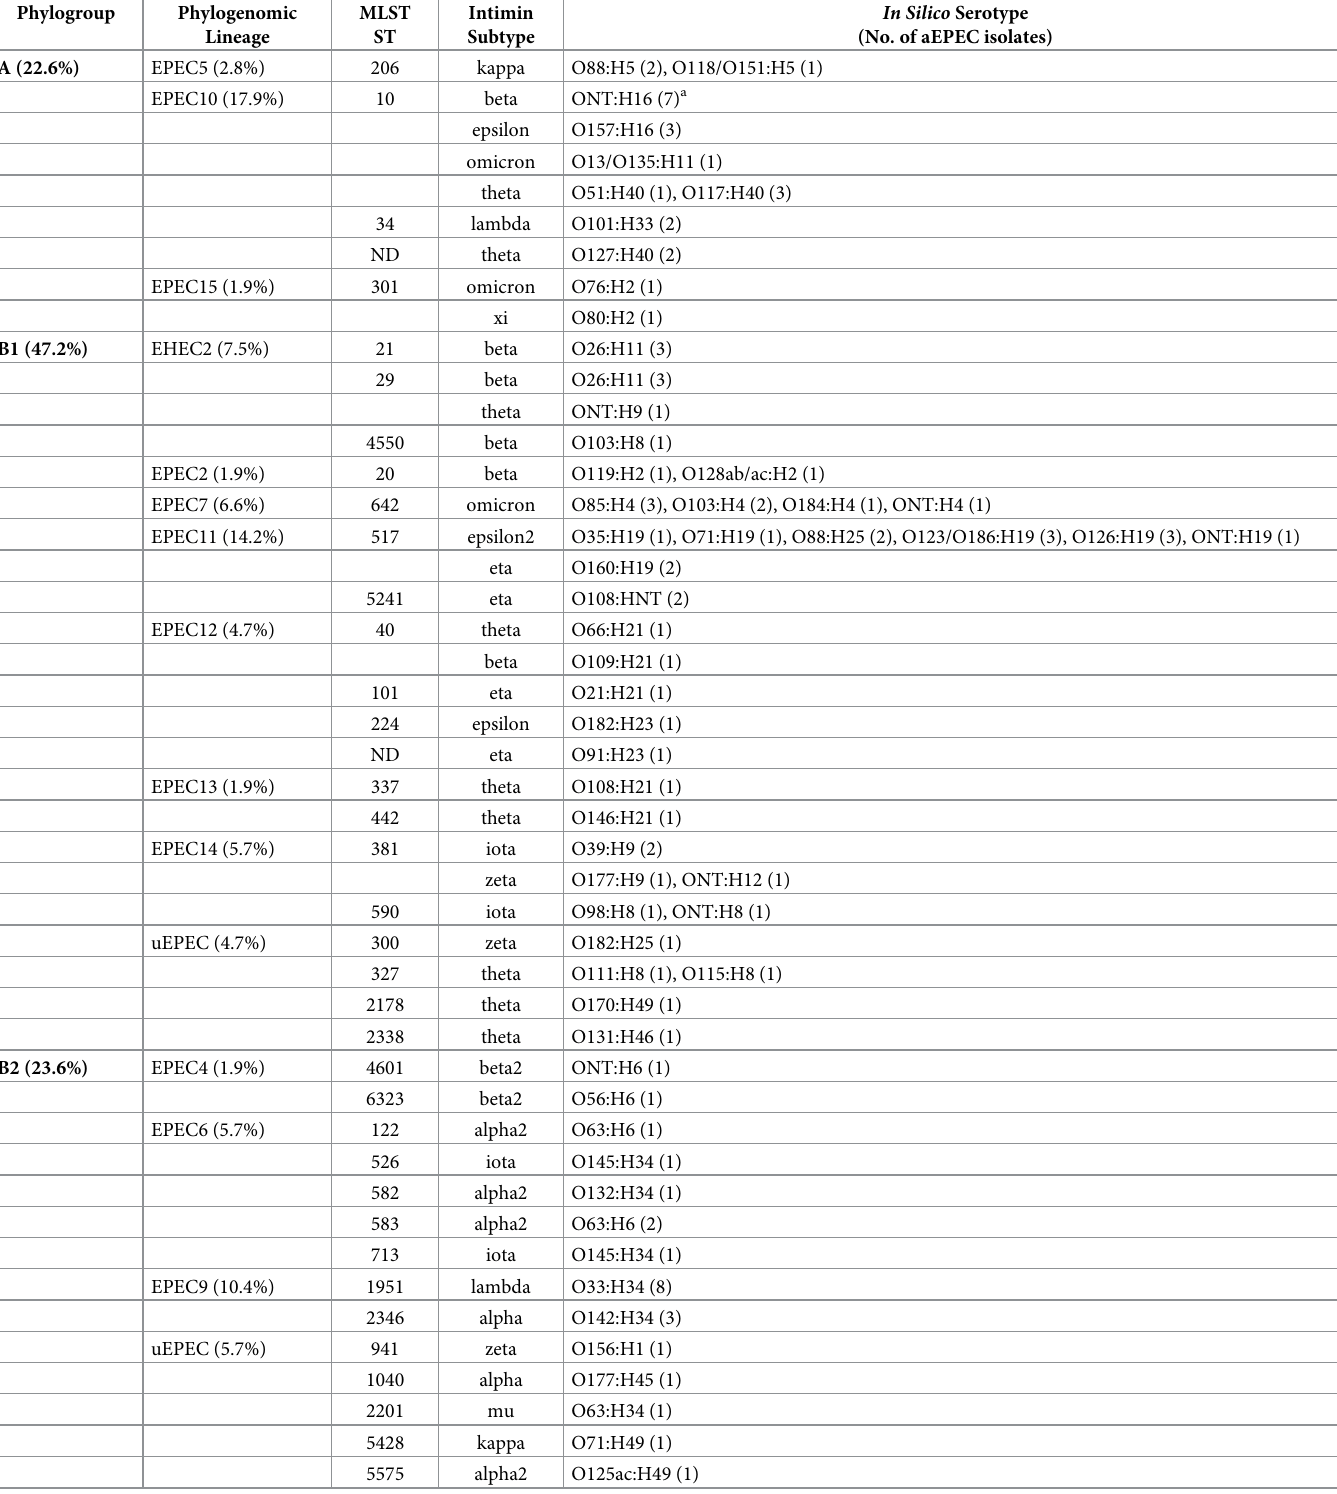
Table 2. Characteristics of the 106 Brazilian aEPEC genomes analyzed in this study.